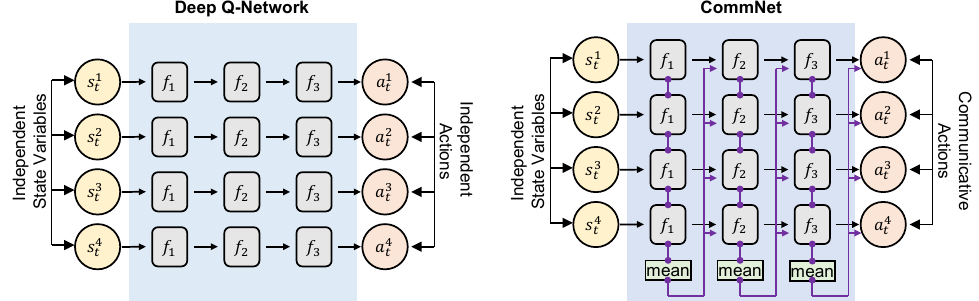
Figure 1. The comparison of deep Q-network and CommNet architectures in terms of the communi- cations among individual agents.